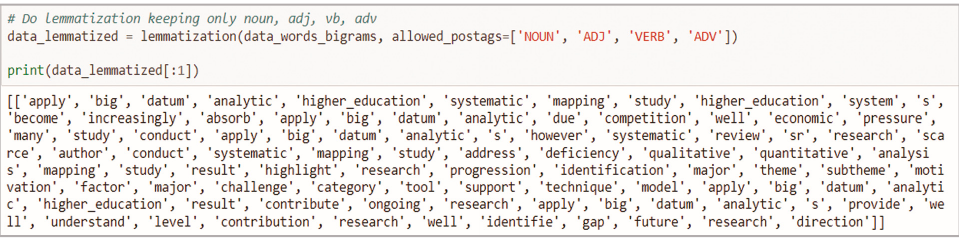
Figure 3. Code 1: POS tagging, own elaboration.